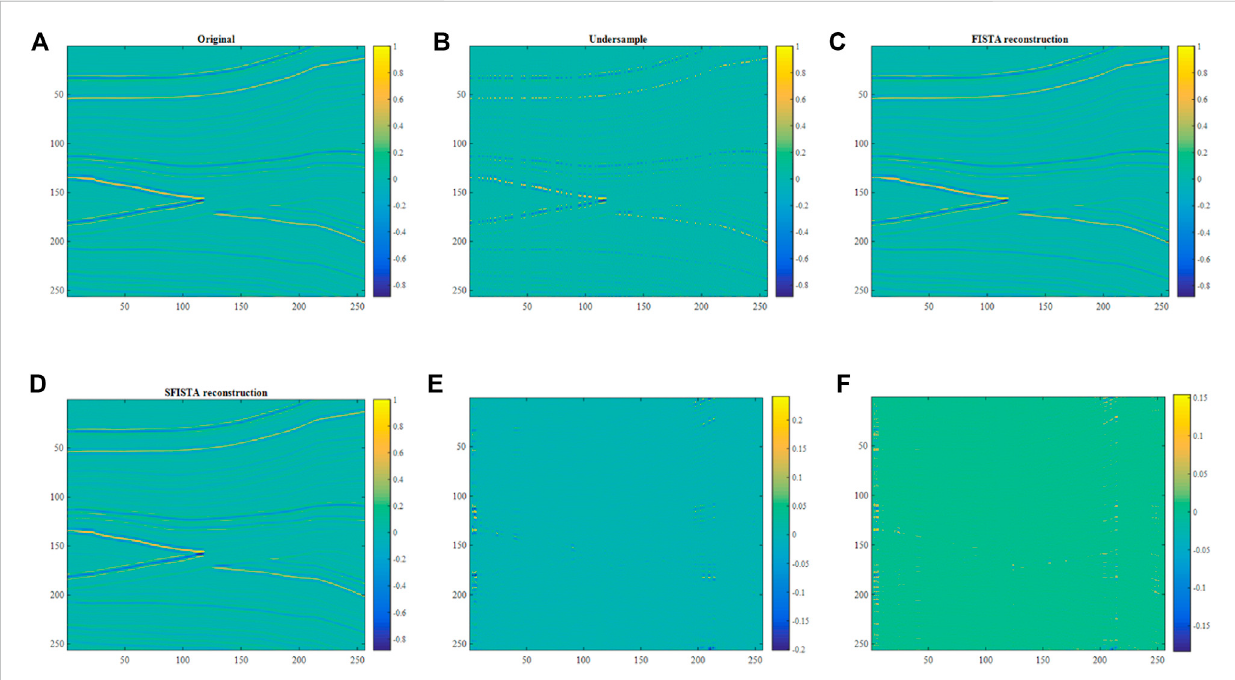
FIGURE 2 Reconstructionresultsofsyntheticdatainthecurveletdomain. (A) Originaldata; (B) 50%ofrandomlymissingdata; (C) interpolateddataobtainedby theFISTA method; (D) interpolated dataobtainedbytheSFISTAmethod; (E) reconstructed errorsobtained bytheFISTA method; (F) reconstructederrors obtained by the SFISTA